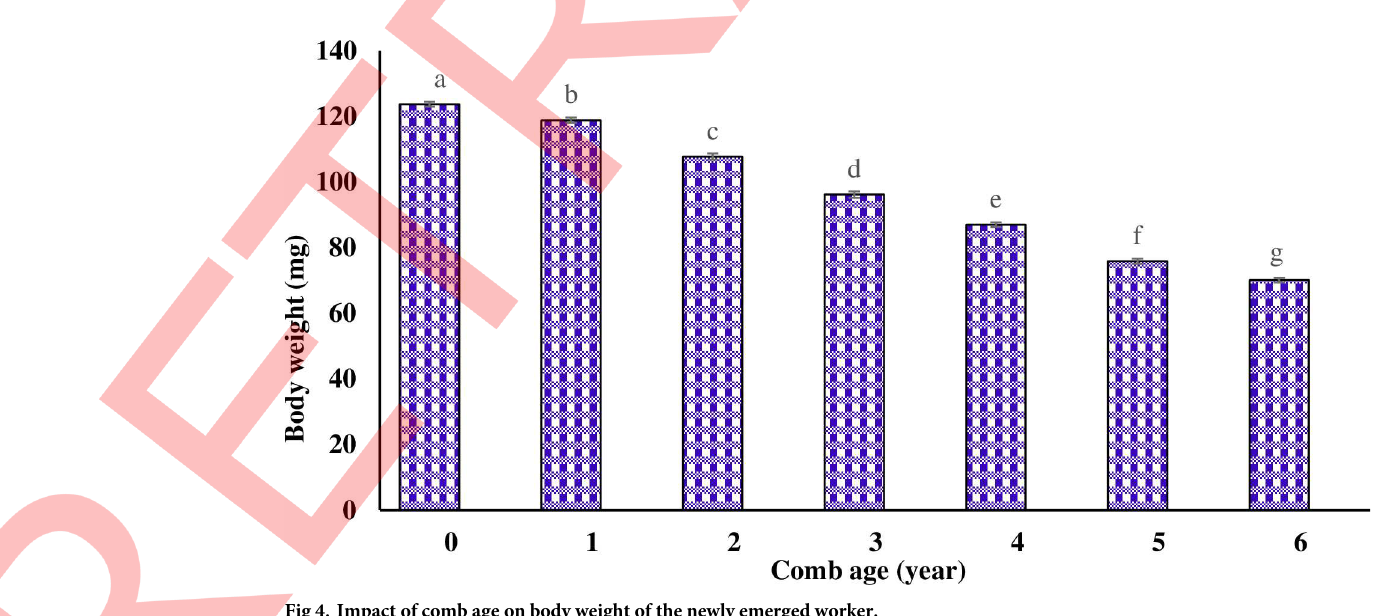
Fig 4. Impact of comb age on body weight of the newly emerged